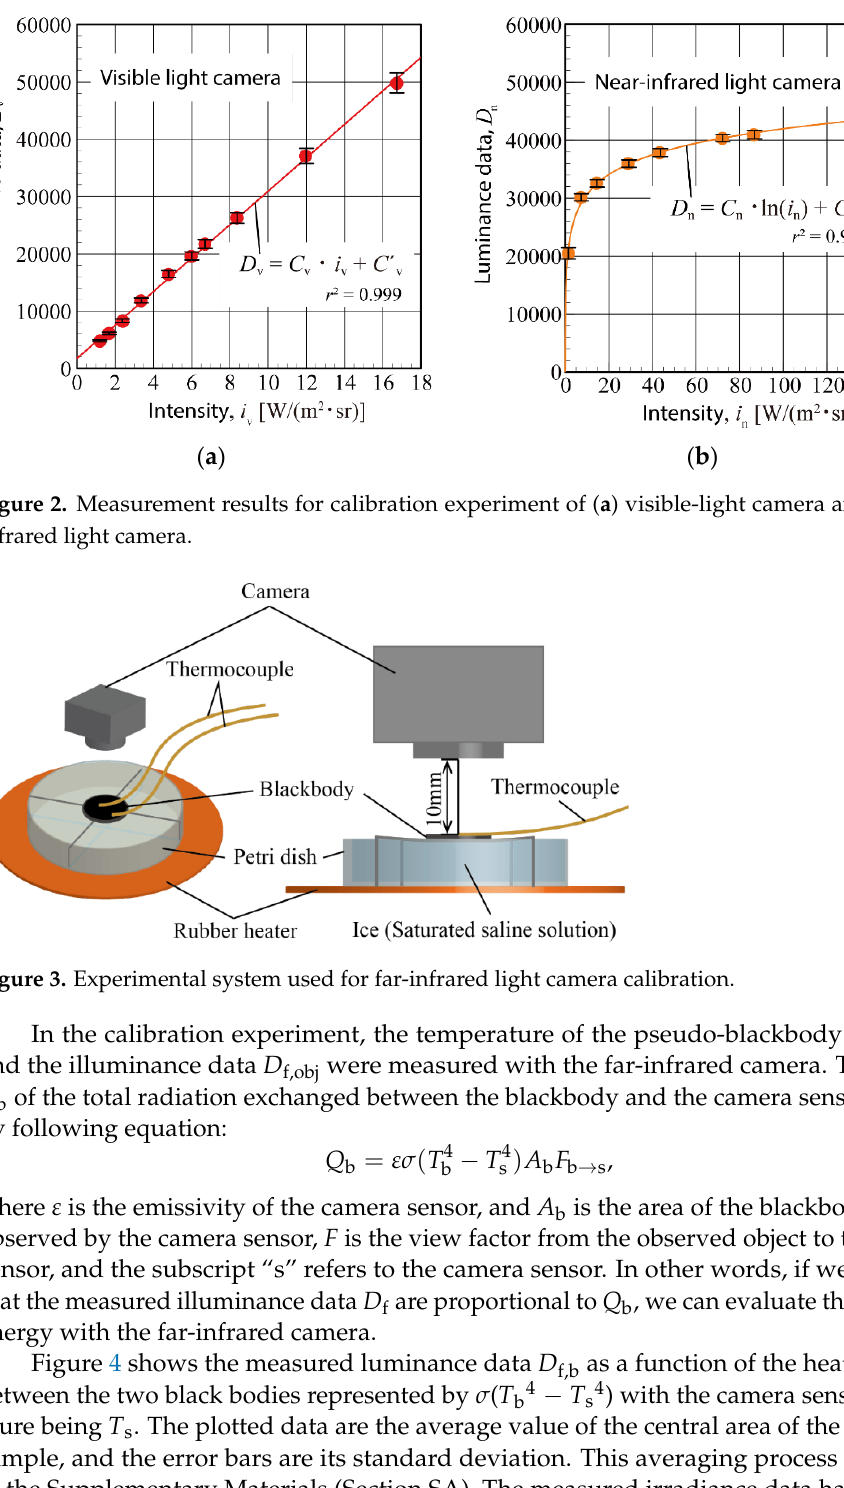
Figure 3. Experimental system used for far-infrared light camera calibration.